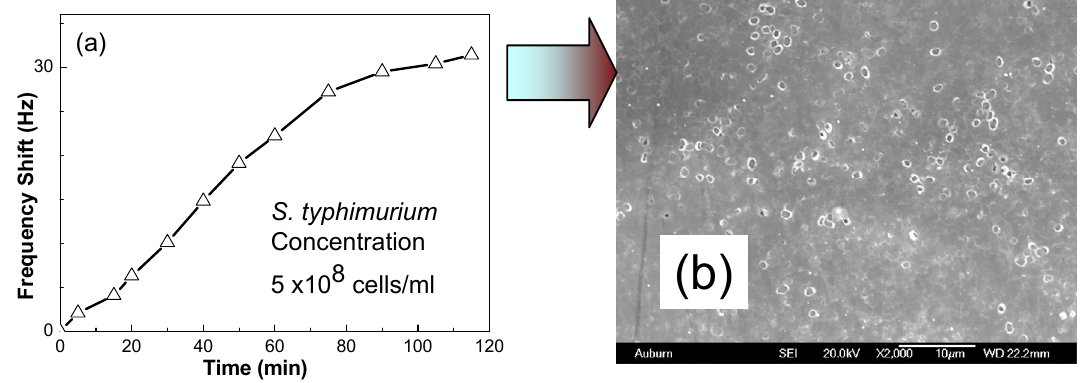
Figure 6. (a). The resonance frequency shifts with time for an MSMC in S. typhimurium suspension with a concentration of 5 x 10 8 cells/ml. (b). SEM images of the MSMC surface after the sensor was exposed to S. typhimurium suspension (5x10 8 cells/ml) for about two